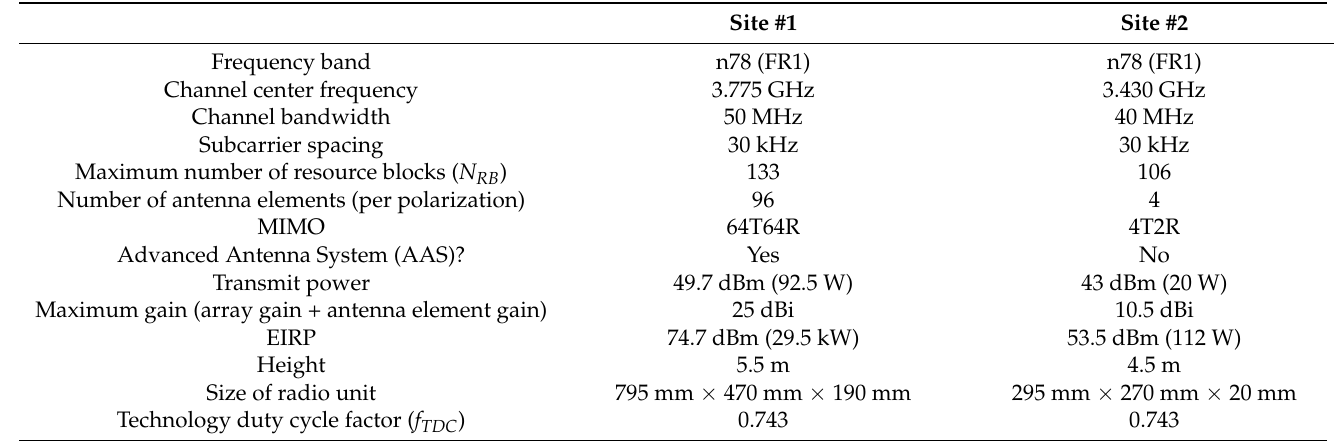
Table 2. Parameters of the 5G new radio (NR) base station radios at the two considered sites in